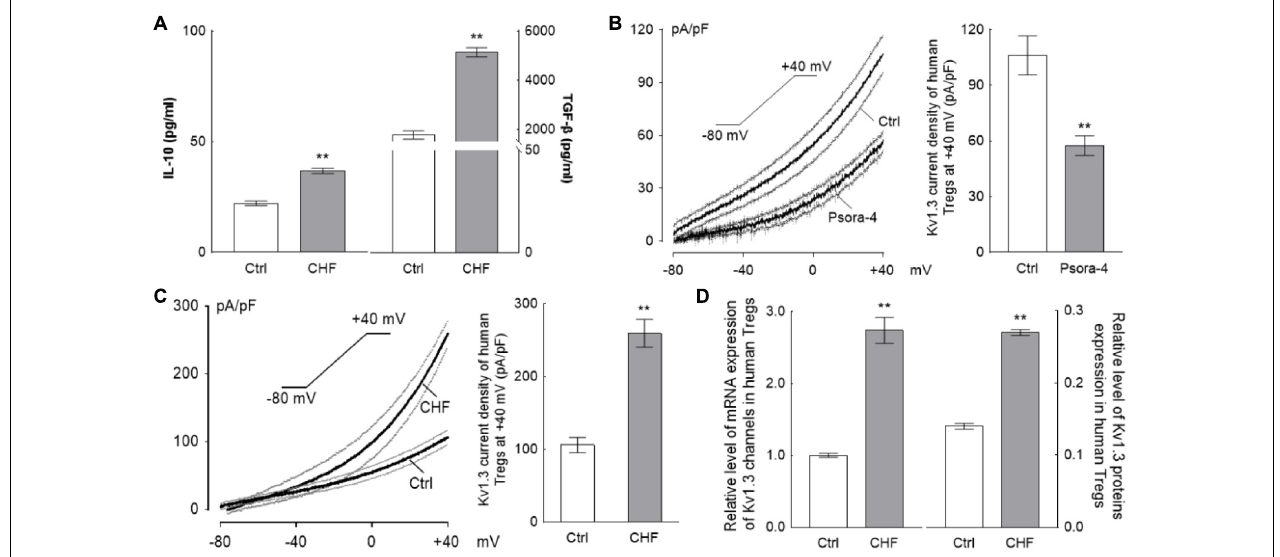
FIGURE 2 | The changing of Tregs activation for CHF patients. (A) The histograms differences of serum IL-10 and TGF- β between the CHF patients and the control persons by ELISA assay. Levels of both IL-10 and TGF- β were elevated significantly in the CHF group compared to the blank control group, nevertheless, the elevation of IL-10 (65.9%) was far less than that of TGF- β (2.9-fold) ( ∗∗ P < 0.01, n = 30 vs. 30). (B) The Kv1.3 channels on the Tregs membrane were identified by perfusion with 3 nM Psora-4 (a specific Kv1.3 channels inhibitor) under voltage ramp from –80 mV to +40 mV of 300 ms duration ( n = 15, the black traces are averaged dots of all the recording cells and the gray lines are standard error dots of them); the histogram on the right of B is the Kv1.3 current density at +40 mV spot. (C) Recording at same protocol on the Treg cells of CHF patients, the elevation of the current density ( ∼ 2.5-fold of the healthy volunteers, n = 22 vs. 20, ∗∗ P < 0.01) was obtained at +40 mV of voltage clamp. (D) Relative level of mRNA and protein expressions of Kv1.3 channels of Tregs of the CHF patients were also elevated significantly compared to the control ( n = 10 vs. 3 for mRNA and n = 6 vs. 6 for protein, ∗∗ P < 0.01). All the above graphs elucidated that during the CHF states, Tregs were activated and secreted cytokines, i.e., IL-10 and TGF- β , though the proliferation of Tregs was suppressed significantly (according to the results of Figure 1 ).